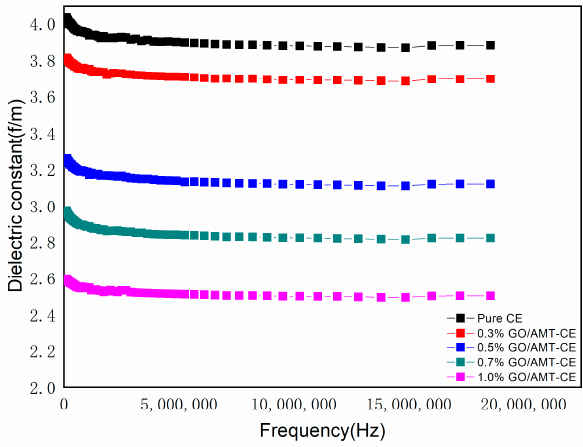
Figure 7. Dielectric constants of GO/AMT-CE composites with different GO/AMT contents.